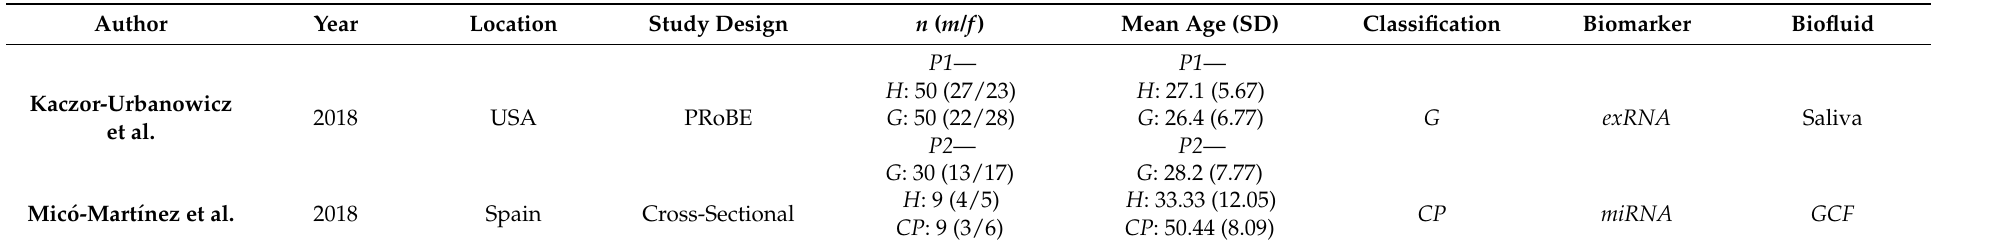
Table 2. Base-line characteristics of studies focusing on the detection of RNA biomarkers in oral biofluids. m , Male; f , Female; H , Periodontally Healthy; CP , Chronic